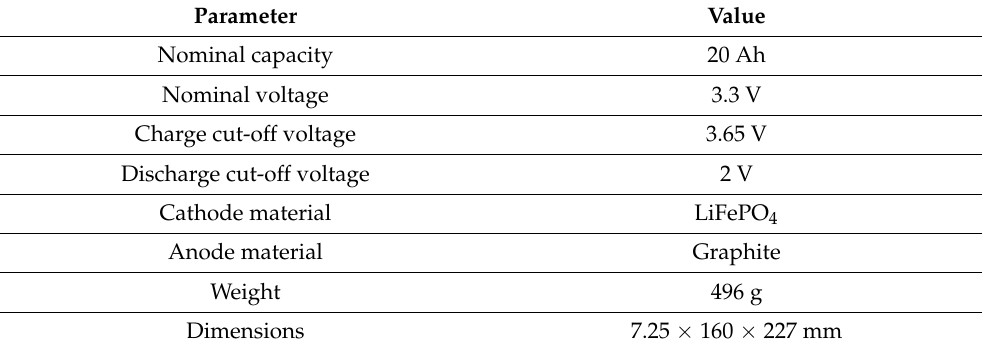
Table 1. The parameters of the